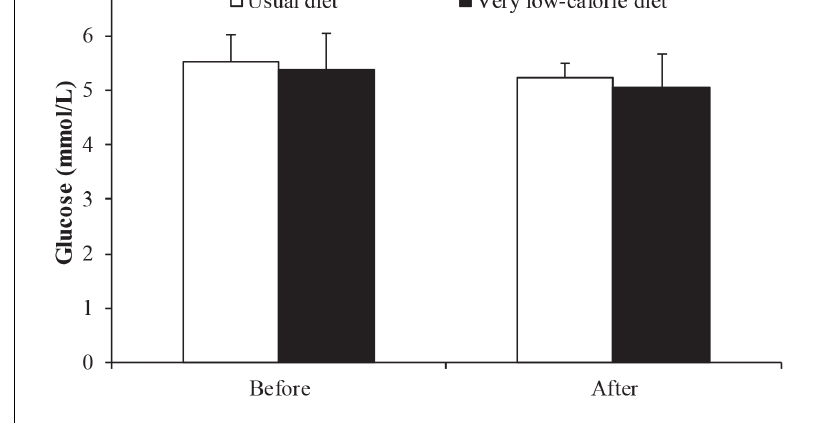
Table 3. Effect of a 2-day very